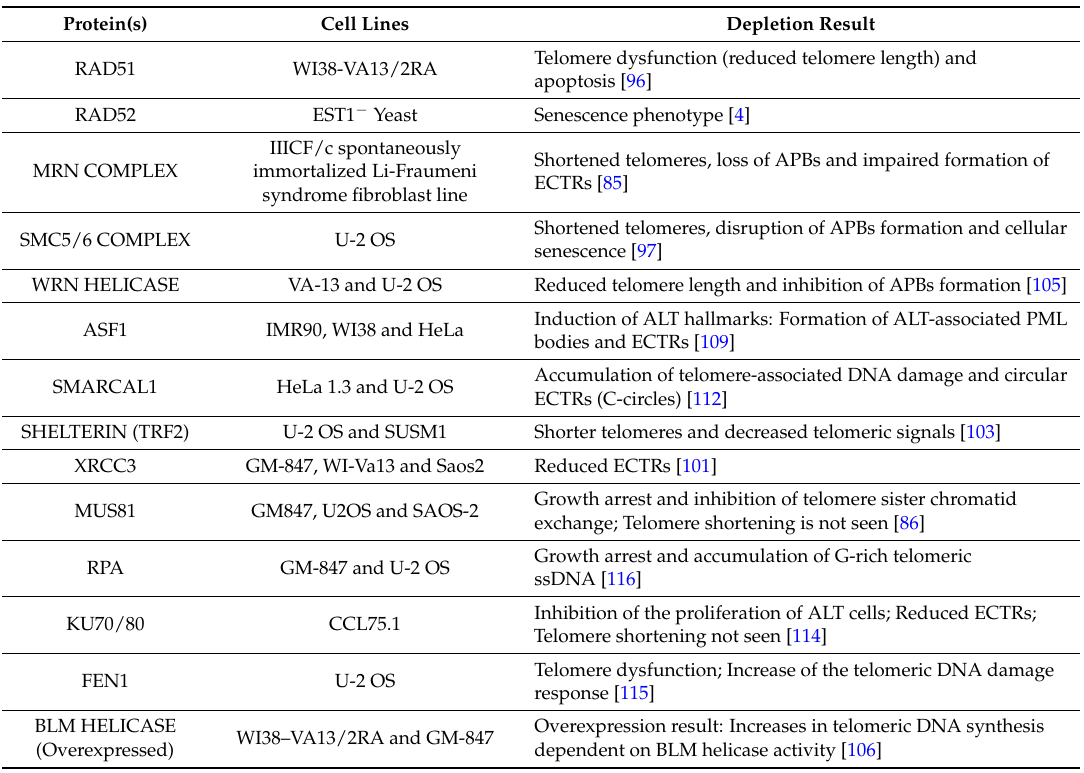
Proteins that, when depleted or overexpressed in ALT cells, produce the listed telomere